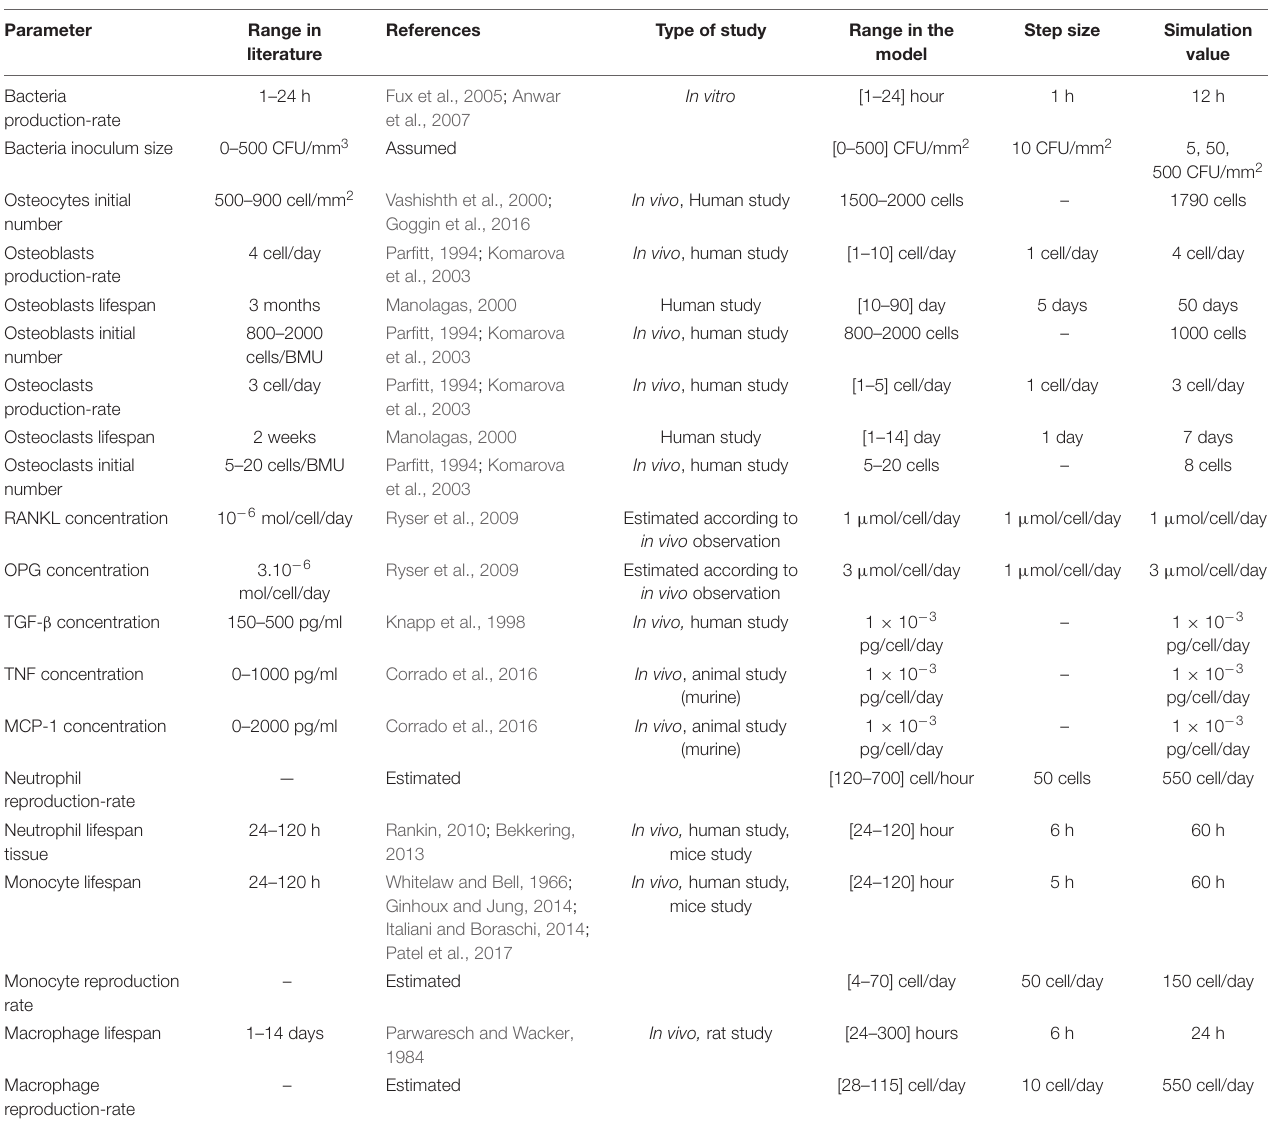
TABLE 3 | The parameters in the model and their values or ranges